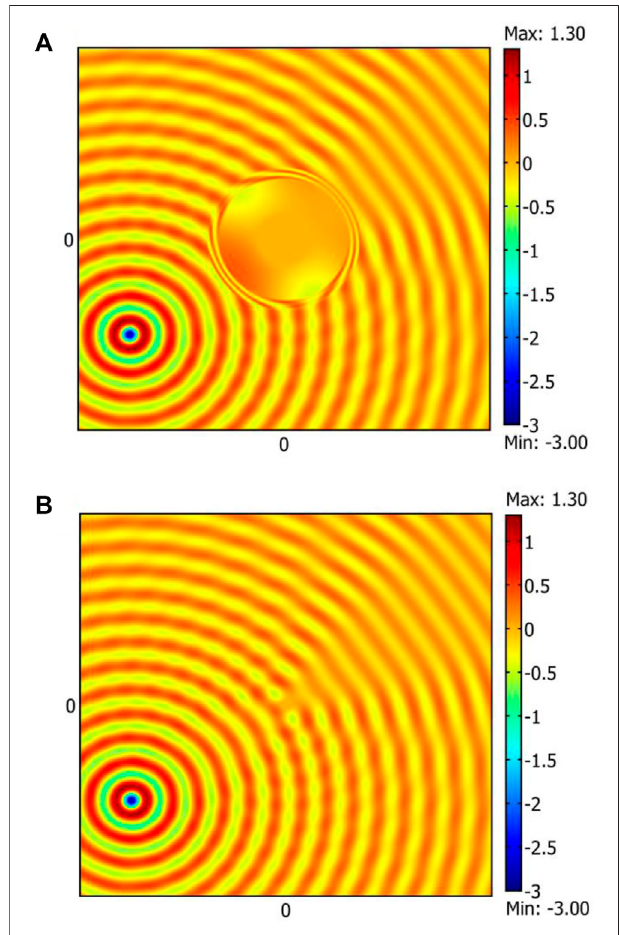
FIGURE 6 | (A) SFP of object placed in core medium of expander and illuminated by near fi eld with b (cid:2) 0 . 3 m , a (cid:2) 0 . 25 m and c (cid:2) 0 . 05 m and d (cid:2) 0 . 1 m asobjectradius.TheobjecthereisPEC. ε sample (cid:2) − 10000 and μ sample (cid:2) 1 (B) SPF of bare transformed object and illuminated by near fi eld with radius d ′ (cid:2) dc / a .Inbothplotworkingfrequencyis1GHZandthepointsource located in. ρ ′ (cid:2) − 0 . 6 i − 0 . 4